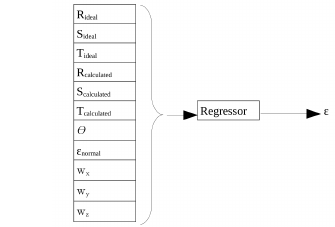
Figure 5. Schematic representation of the information that the regressor receives as input and returns as output (estimated value of (cid:101) ). On the left, the inputs are the coefficients of the ideal and calculated planes and θ value. On the right, four new features have been added as inputs: the coefficients of the axis of rotation between normals and (cid:101) normal